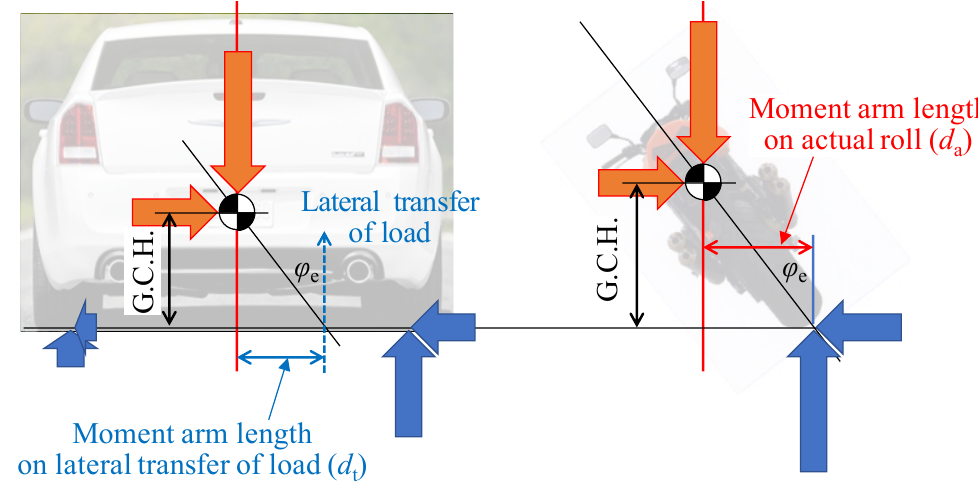
Figure 24. Roll moment balance on car and